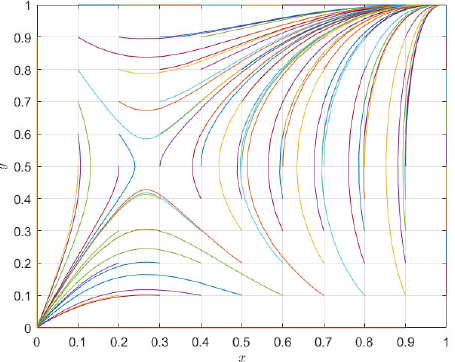
Figure 3. System evolution path diagram of pharmaceutical enterprises and 3PL institutions.